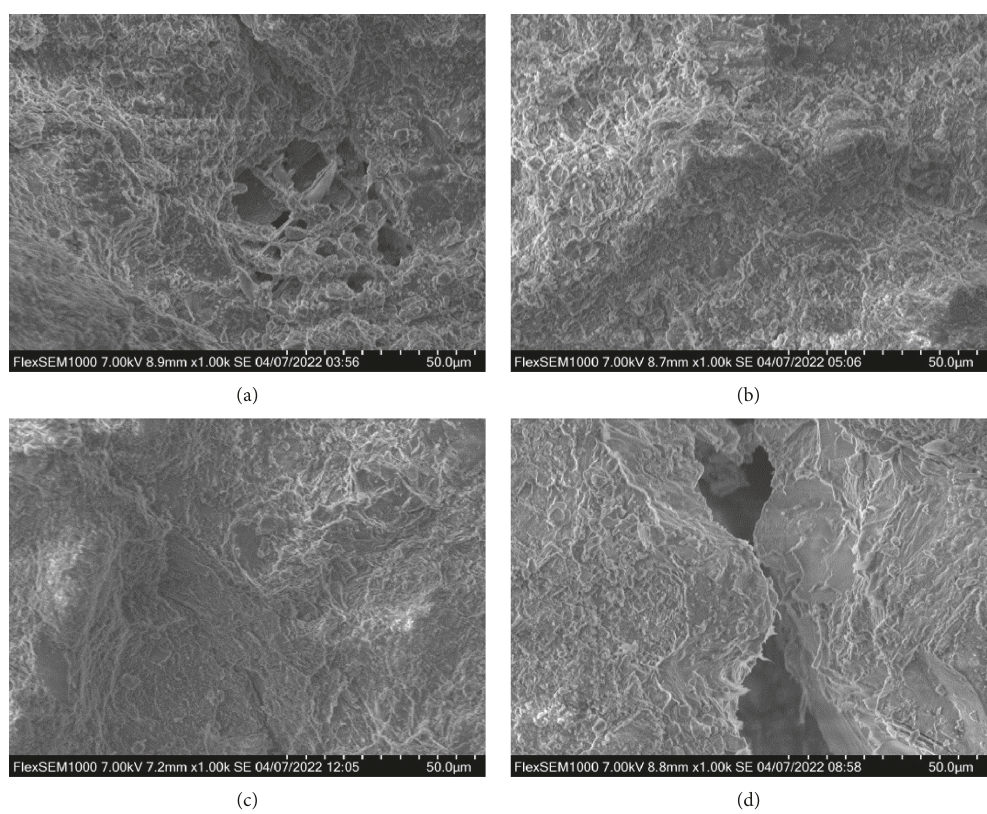
Figure 7: SEM images of sandstone after different temperatures ( × 1000): (a) 25 ° C, (b) 200 ° C, (c) 300 ° C, and (d) 500 ° C.